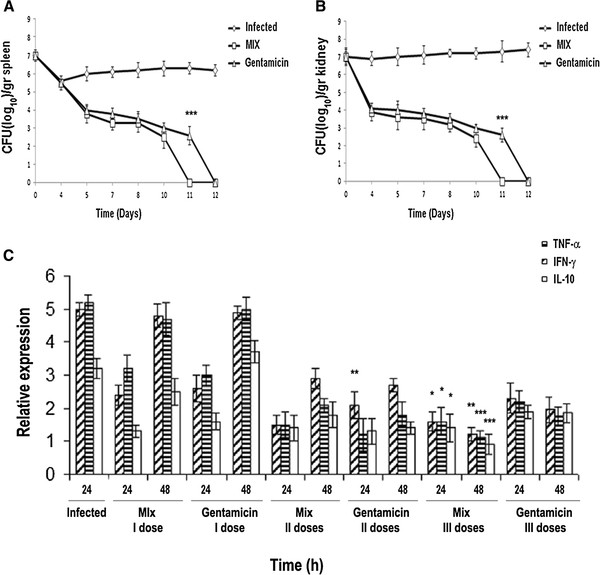
(A-B) Bacterial load in spleen and kidneys of animals (24/groups) infected with Staphylococcus epidermidis (107 CFU/mouse; rumble line); infected with Staphylococcus epidermidis(107 CFU/mouse) and treated with the MIX (RJI-C at 9 μg/mouse and TB-KK at 6 μg/mouse; square line) or gentamicin (5 μg/mouse; triangle line) *P <0.05, **p < 0.01; ***p < 0.001, Student’s t test gentamicin vs MIX. (C) TNF-α, IFN-γ, IL-10 mRNA expression levels were quantified, at the indicated time points, in mice infected with Staphylococcus epidermidis (107 CFU/mouse) or infected with Staphylococcus epidermidis (107 CFU/mouse) and treated with three different doses (I,II,III) of the MIX (RJI-C at 9 μg in 100 μl/mouse and TB-KK at 6 μg in 100 μl/mouse) or gentamicin (5 μg in 100 μl/mouse). Values were normalized with GAPDH and compared to untreated control. *P <0.05, **p < 0.01; ***p < 0.001, Student’s t test gentamicin vs MIX.